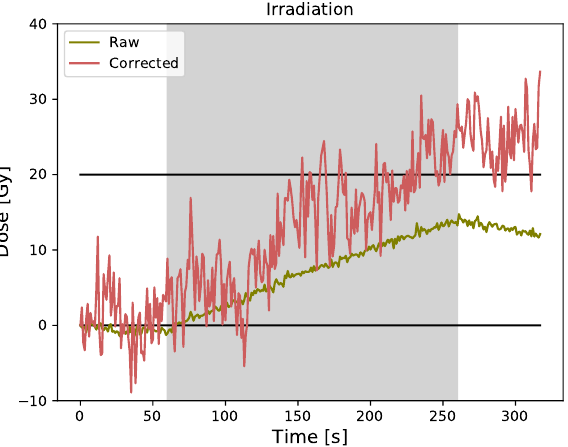
Figure 3. Raw and corrected data for PMMA-coated FBG obtained using the bare fiber as ambient temperature detector (dual grating